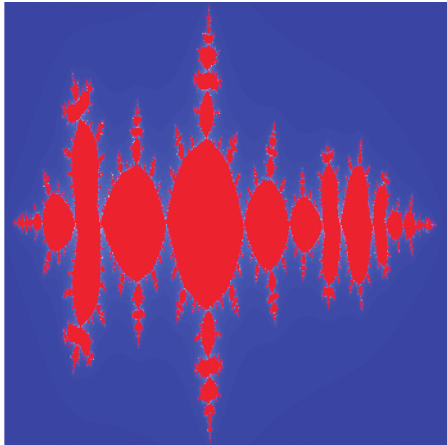
Figure 4: Quadratic Julia set in JSOmhh.